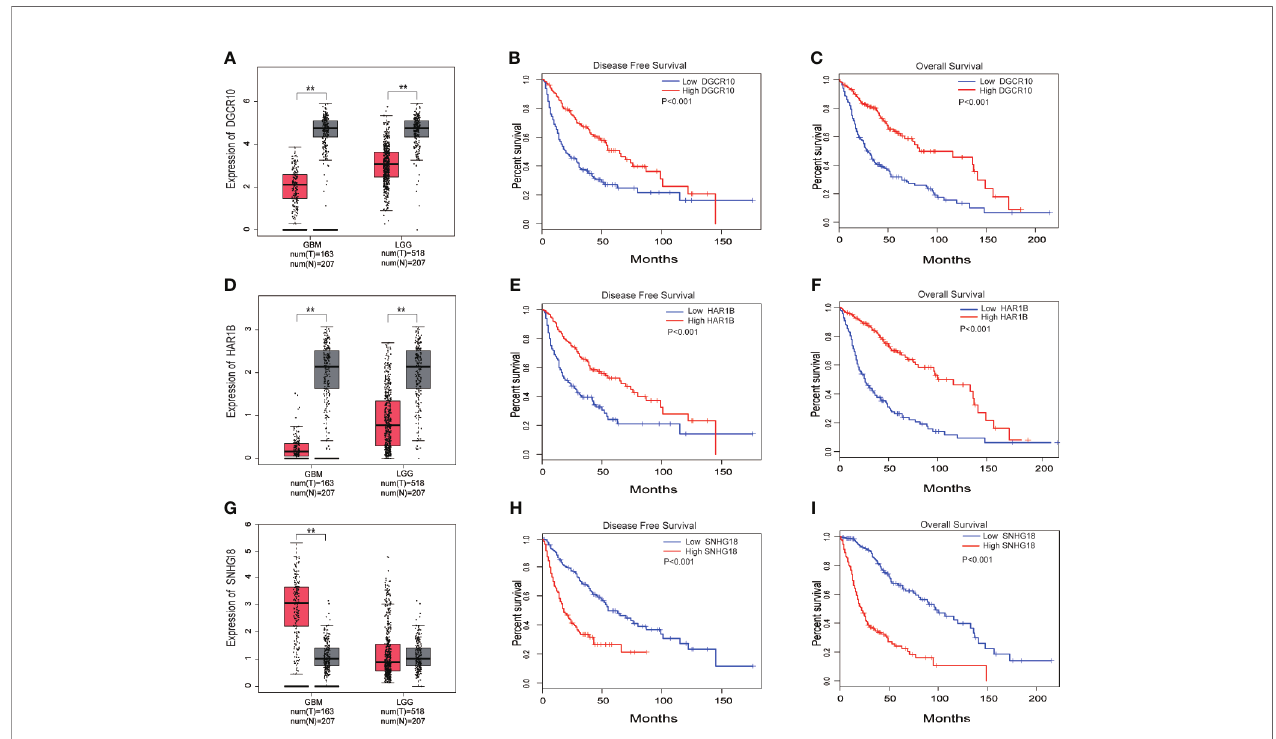
FIGURE 8 | DGCR10, HAR1B, and SNHG18 were selected from the 10 MES-related lncRNAs. (A) Differences in DGCR10 expression between the normal and glioma groups from the TCGA and GTEX data sets. (B) Disease-free survival analysis of DGCR10 from the TCGA database. (C) Overall survival analysis of DGCR10 from the TCGA database. (D) Differences in HAR1B expression between the normal and the glioma groups from the TCGA and GTEX data sets. (E) Disease-free survival analysis of HAR1B from the TCGA database. (F) Overall survival analysis of HAR1B from the TCGA database. (G) Differences in SNHG18 expression between the normal and glioma groups from the TCGA and GTEX data sets. (H) Disease-free survival analysis of SNHG18 from the TCGA database. (I) Overall survival analysis of SNHG18 from the TCGA database. **p <